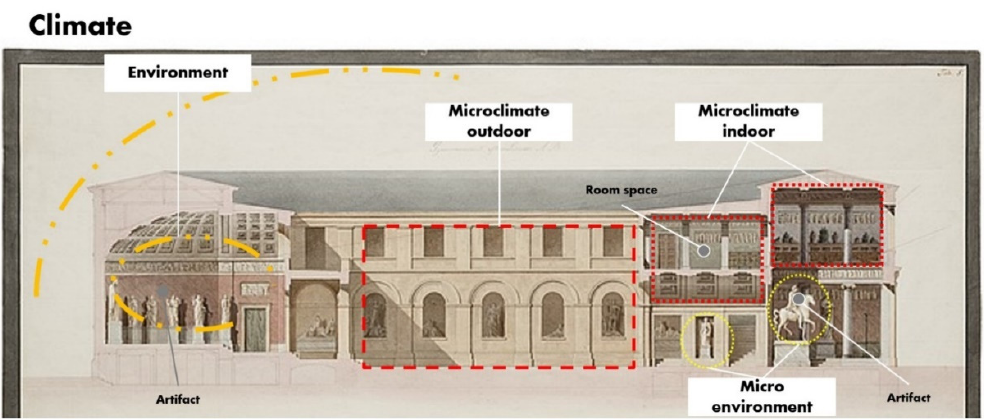
Figure 1. Graphical scheme of nomenclature.